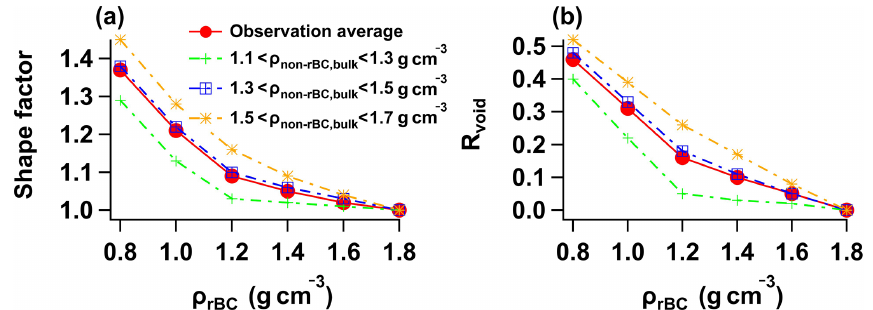
Figure 3. The shape factor and void fraction of BC-containing particles under different effective densities.